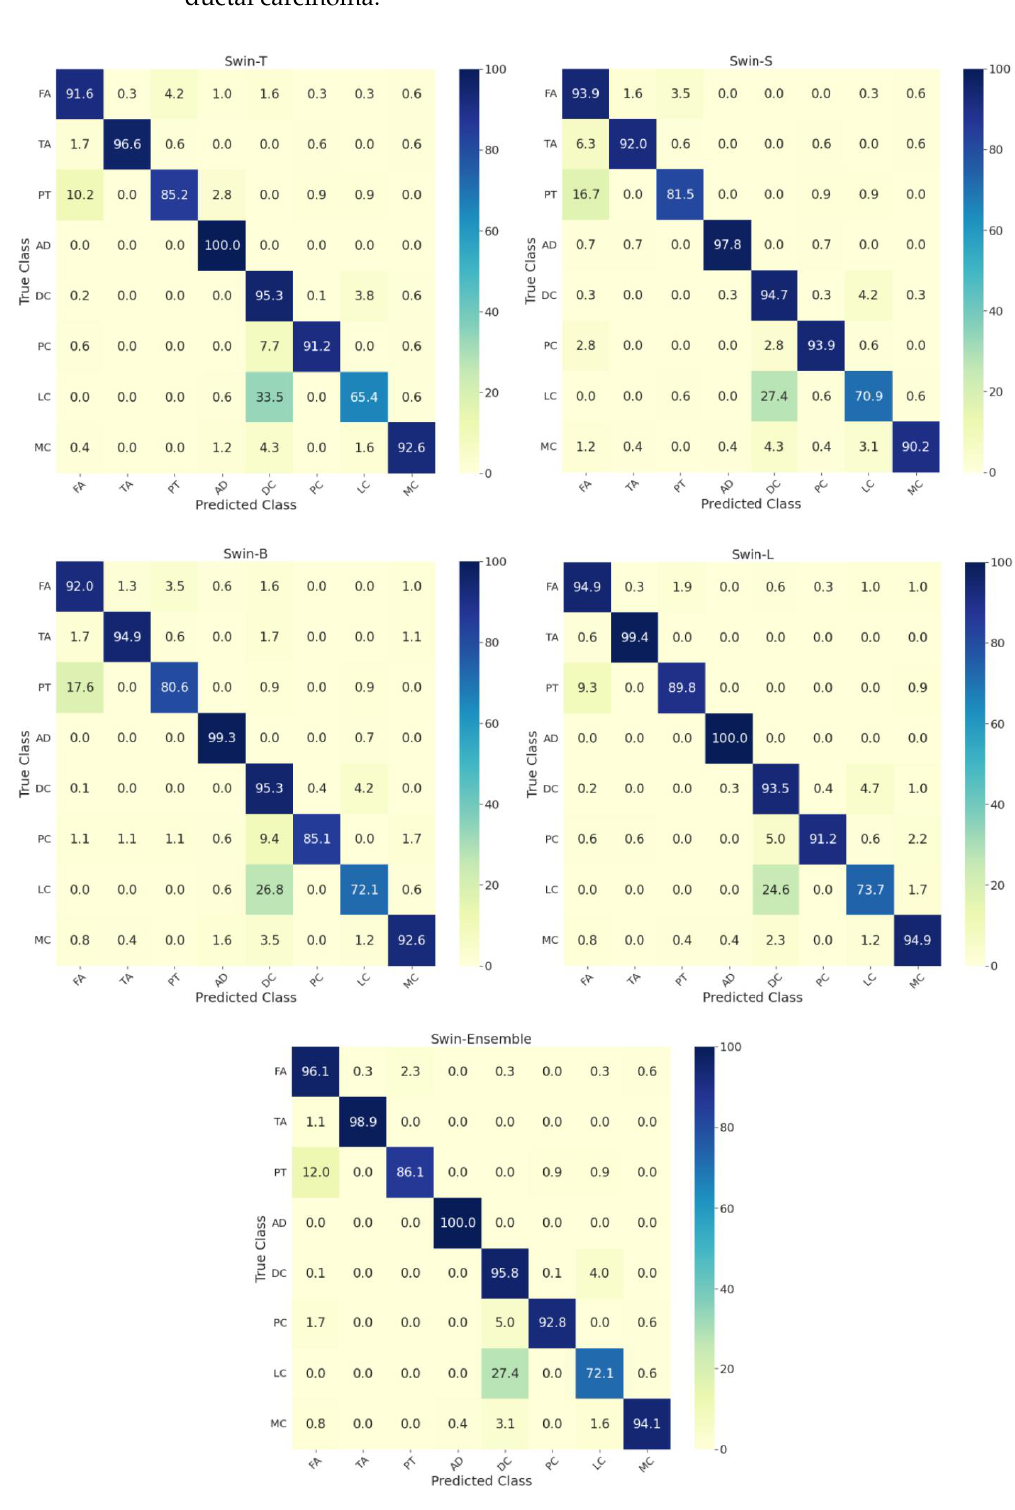
Figure 4. Confusion matrices on the test set for the eight-class classification of benign and malignant subtypes for each swin transformer model by considering images from all zoom factors. T: tiny, S: small, B: base, L: large. FA: fibroadenoma, TA: tubular adenoma, PT: phyllodes tumor, AD: adenosis, DC: ductal carcinoma, PC: papillary carcinoma, LC: lobular carcinoma, MC: mucinous